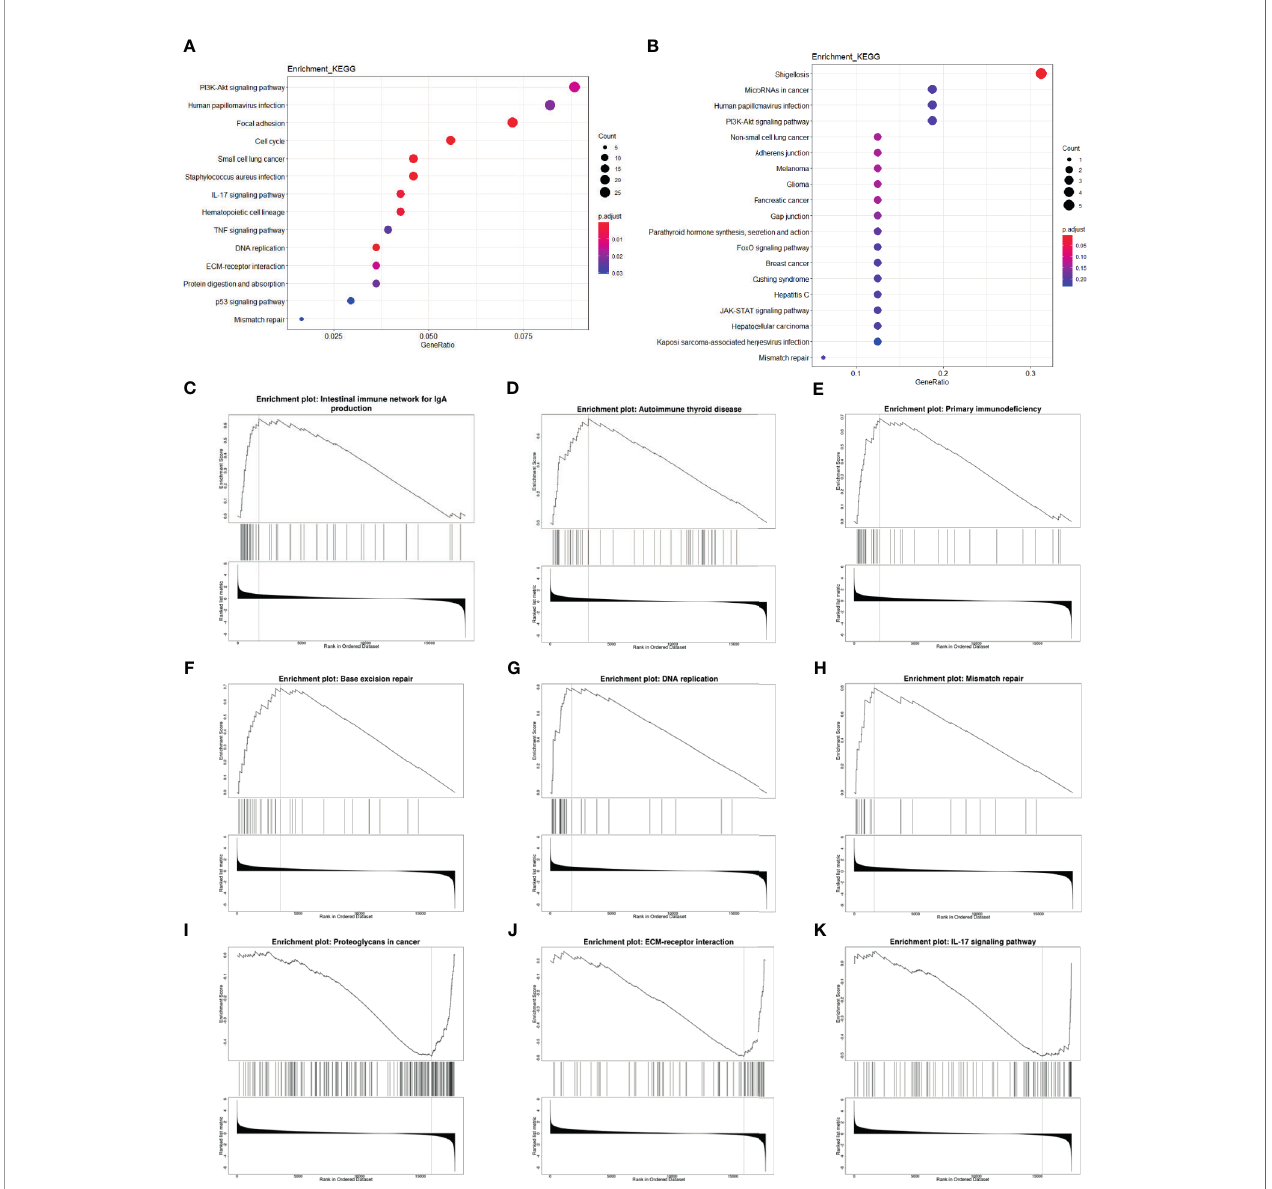
FIGURE 6 | Enrichment analysis of mRNA and miRNA targets. (A, B) Top KEGG-enriched terms of differentially expressed genes and differentially expressed miRNA target genes, respectively. (C – K) GSEA-enriched terms, in which genes were sorted by